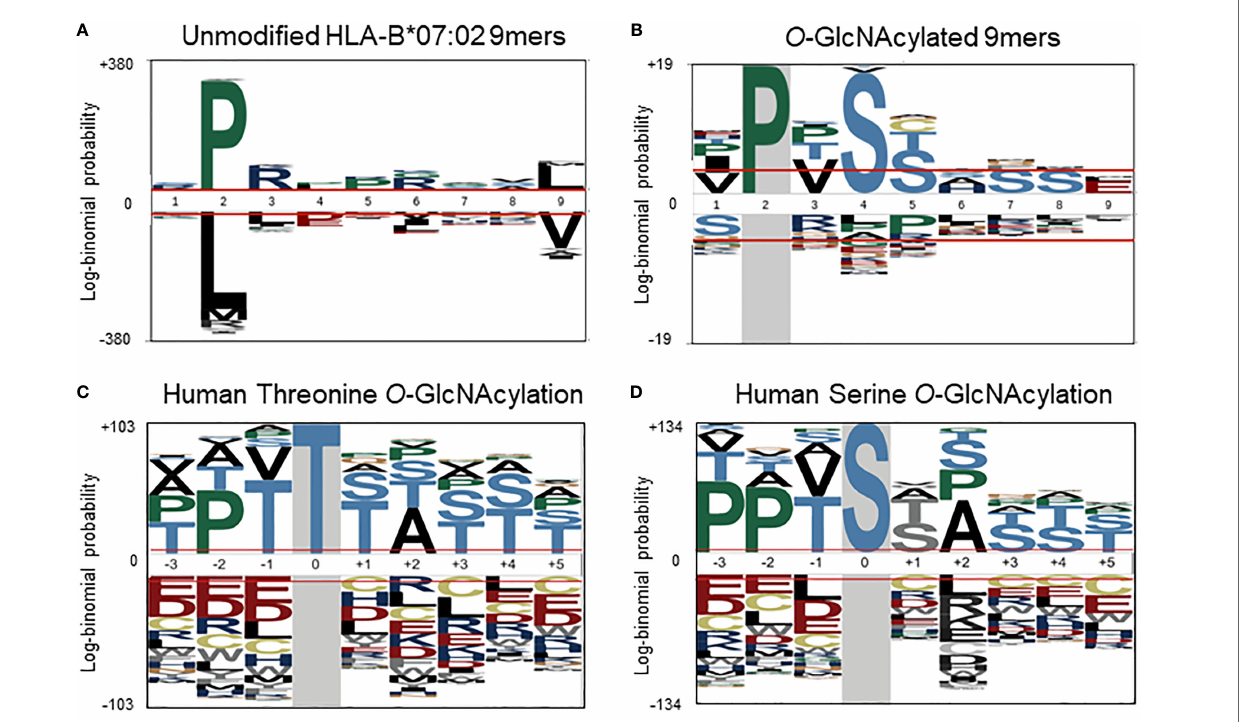
FIGURE 3 | (A) Sequence motif (pLogo) of the in the current study detected unmodi fi ed HLA-B*07:02 peptides (9-mers) predicted as binders (% Rank < 2), with the clear anchoring positions Pro at P2 and Leu at P9. (B) Sequence motif of the O -GlcNAcylated HLA peptides (9-mers), with next to Pro at P2, Val at P3 and Ser at P4 and P5. Semi-consensus sequences based on the 7002 human O-GlcNAcylation sites for (C) Threonine and (D) Serine O-GlcNAcylation. (adapted from Wuff- Fuentes et al. (https://creativecommons.org/licenses/by/4.0/legalcode).